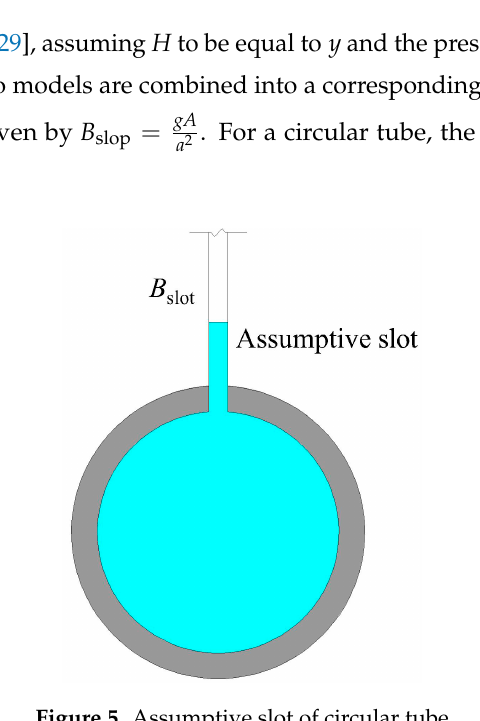
Figure 5. Assumptive slot of circular tube.